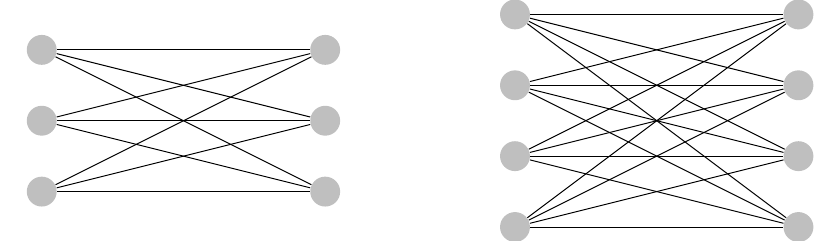
Figure 6 . On the left is the orbifold groupoid for a theory with Z 2 × Z 2 symmetry. On the right is the orbifold groupoid for a theory with Z number of vertices in a graph is 2( p + 1) and the orbifold groupoid, with just Z is the complete bipartite graph K